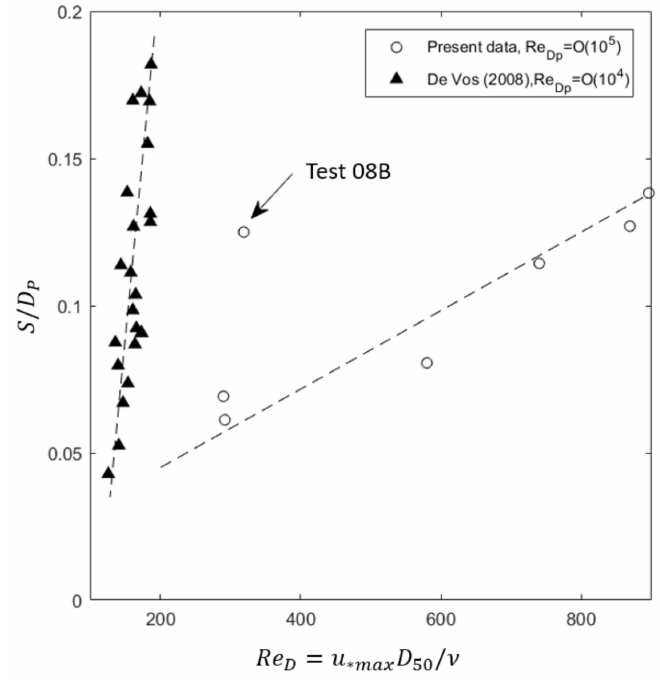
Figure 16. Relation between S / D P and Re D after 3000